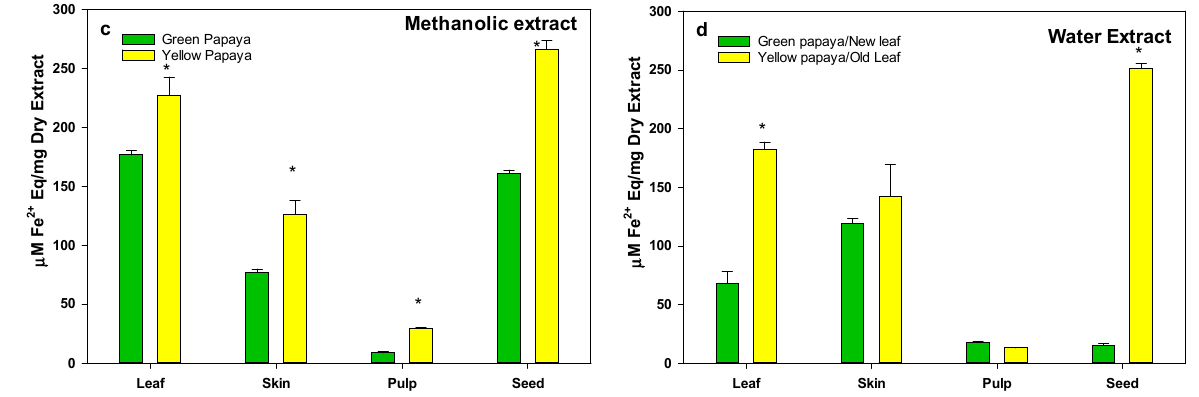
Figure 3. Anti-oxidation activity in green and yellow papaya fractions. The anti-oxidation activity in green and yellow papaya was determined using DPPH (2,2-diphenyl-1-picryhydrazyl) and FRAP (ferric-reducing antioxidant potential (FRAP)) assays as described in the text. The experiment was conducted in triplicate and data were expressed as μ M of Trolox equivalents (TE)/g of dried sample ( a , b ) or μ M of FeCl 3 equivalent/g dry extract ( c , d ). The statistical analysis was performed using Student’s t test between green and yellow papaya. The significant difference is represented by “*” at p < 0.05.